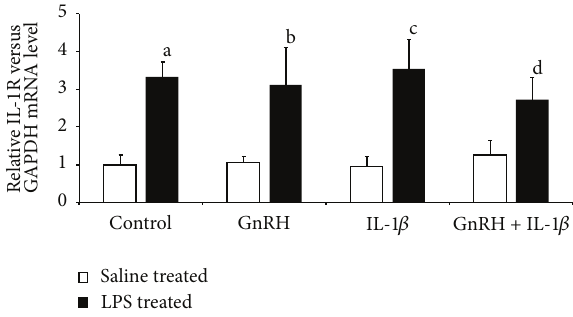
Figure 2: Inhibitory effect of IL-1 𝛽 on LH 𝛽 gene expression in the AP explants collected from saline- and LPS-treated ewes and incubated in four types of media (control—“pure” medium 199 HEPES; GnRH—medium with GnRH (100pmol/mL); IL-1 𝛽 — medium with IL- 𝛽 (100pg/mL); GnRH + IL-1 𝛽 medium with GnRH (100pmol/mL) and IL- 𝛽 (100pg/mL)). Data are presented as a median value ± SEM. a,b,c— 𝑃 ≤ 0.01 (indicating values that differ significantly from the control, GnRH, and IL-1 𝛽 groups of saline-treated explants, respectively, according to the Mann- Whitney 𝑈 test) and e,f— 𝑃 ≤ 0.01 (indicating values that differ significantly from the control and GnRH groups of LPS-treated explants, respectively, according to the Mann-Whitney 𝑈 test).